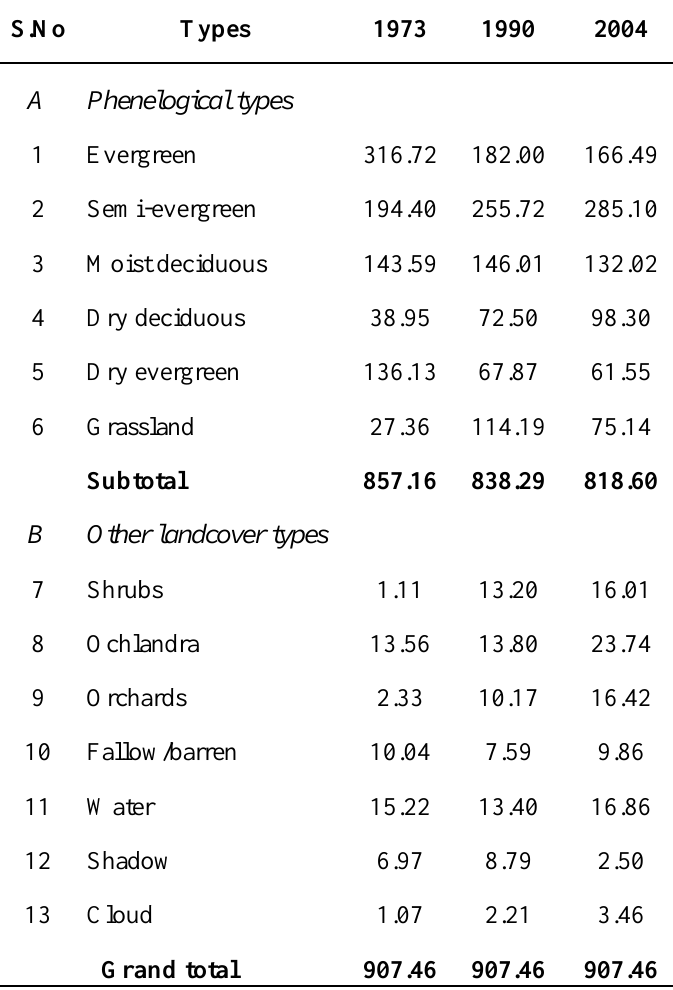
Table 1. Vegetation and land-cover distribution in KMTR, South Western Ghats, Tamil Nadu, India for the years 1973 and 2004 using